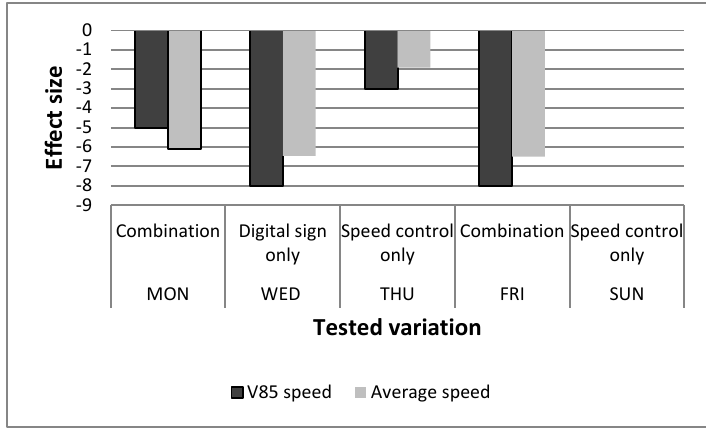
Figure 4. Effects on average speed and V85 speed for 3 types of interventions (regional police unit 2).